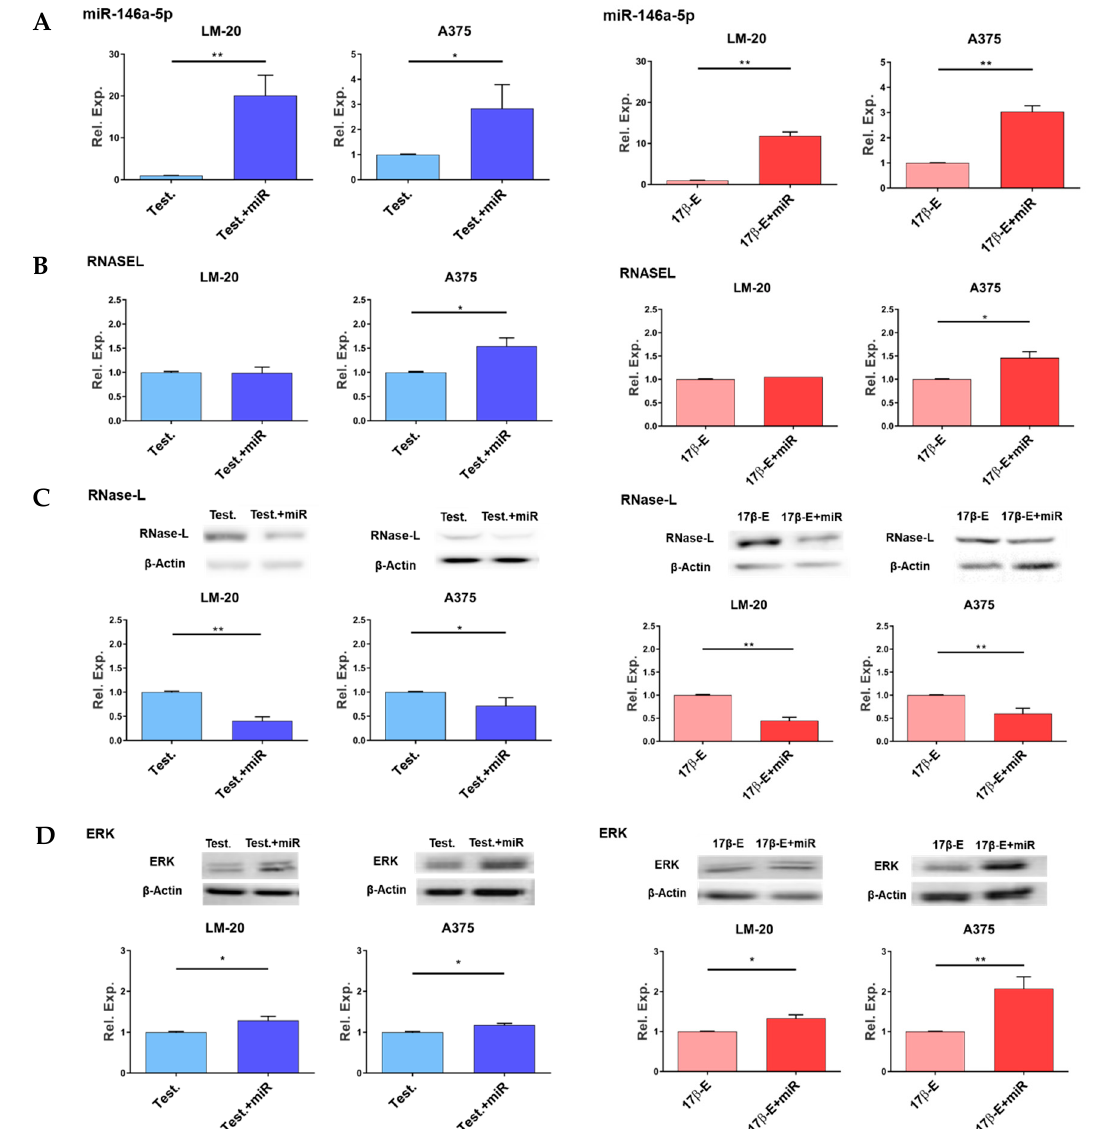
Figure 2. Effects of miR-146a mimic transfection on RNASEL gene, RNase-L protein, and phosphorylated extracellular signal-regulated kinases (pERK)1/2 expression levels in the presence of hormones. ( A ) Increase of miR-146a gene expression after miR-146a mimic transfection in the presence of either testosterone or 17 β -estradiol in comparison with negative controls; ( B , left) RNASEL transcript level in the presence of testosterone with (blue) or without (light blue) miR-146a mimic. ( B , right) RNASEL transcript level in the presence of 17 β -estradiol with (red) or without (pink) miR-146a mimic. ( C , left) RNase-L protein level in the presence of testosterone with (blue) or without (light blue) miR-146a mimic. ( C , right) RNase-L protein level in the presence of 17 β -estradiol with (red) or without (pink) miR-146a mimic; ( D ) measure of the amount of the phosphorylated form of kinases ERK1/2 in the presence of each hormone. All the results are reported as a mean value ± S.D. Differences in relative expression were analyzed with GraphPad Prism statistical program, using unpaired, two-tailed Student’s t -test: * p < 0.05; ** p < 0.01.